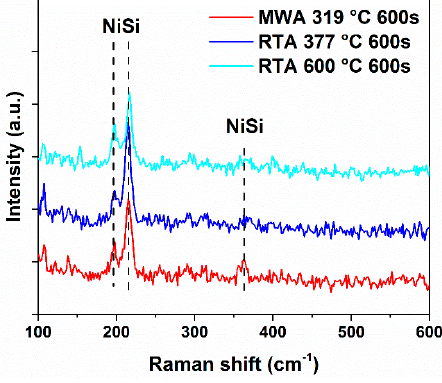
Figure 2. Raman spectra of the n-type samples.